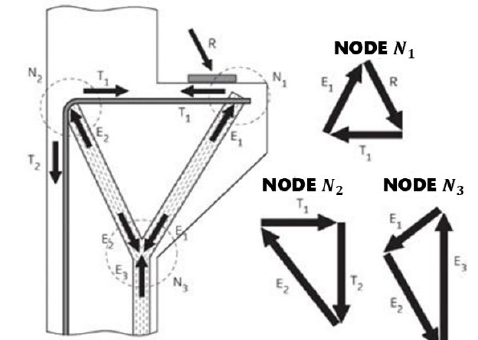
Figure 1. Static scheme of a strut and tie model for a short